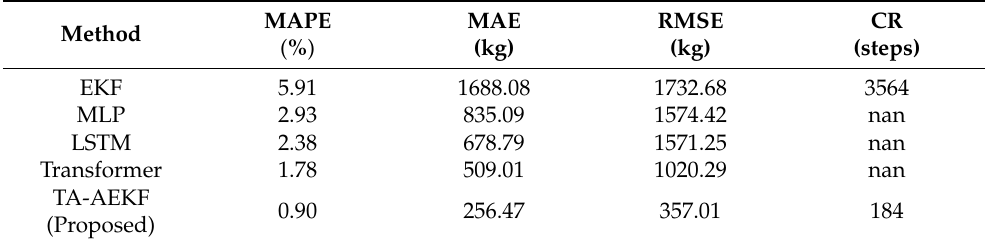
Table 4. Evaluation metrics of simulation test 1 & 2 average